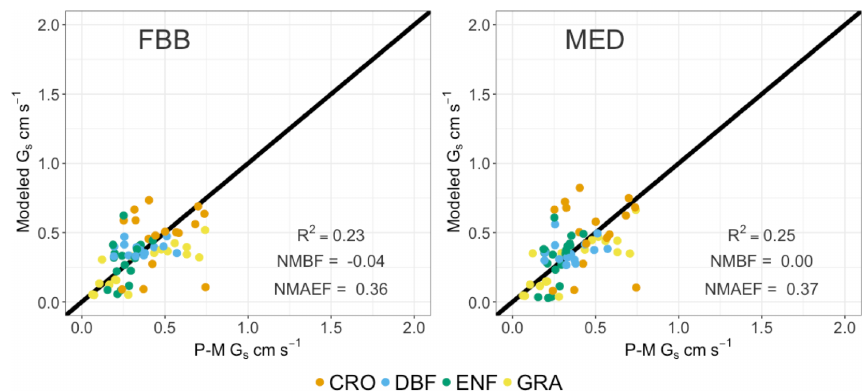
Figure 7. FBB and MED using g 1B and g 1M derived from mean annual precipitation data compared with SynFlux canopy stomatal conduc- tance ( G s ) during growing seasons. Each point indicates average daytime G s for the major PFT at an individual FLUXNET site.